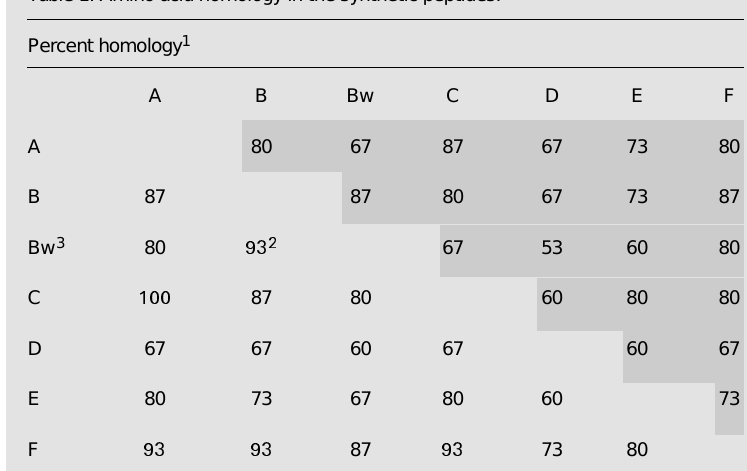
Table 1. Amino acid homology in the synthetic